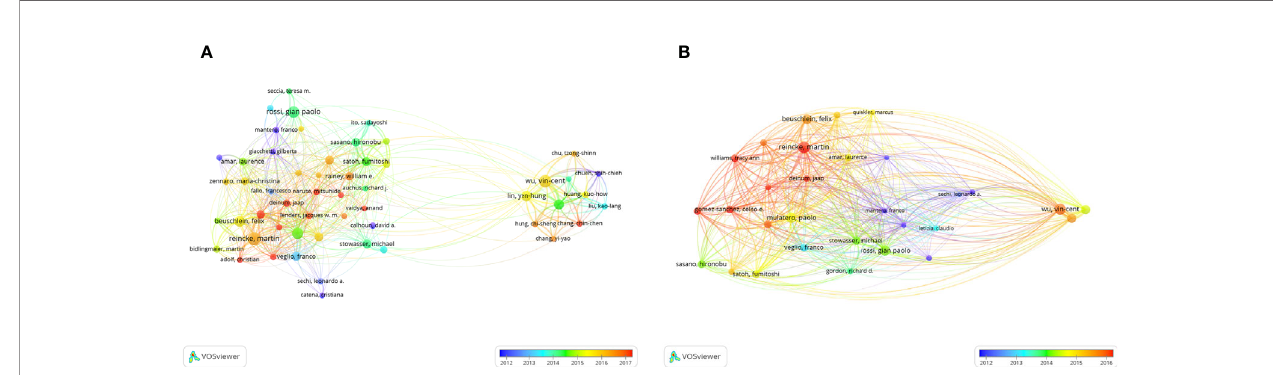
FIGURE 5 | The distribution of authors in PA research. (A) Author co-authorship overlay visualization map. The color of each circle corresponds to the average publication year of the author, the size of a circle is proportional to the number of literatures published by the author, and the thickness of the connecting line indicates the cooperation frequency. (B) Author co-citation overlay visualization map. The color of each circle corresponds to the average publication year of the author, the size of a circle is proportional to the total number of citations of the author, and the thickness of the connecting line indicates the strength of the co- citation link.